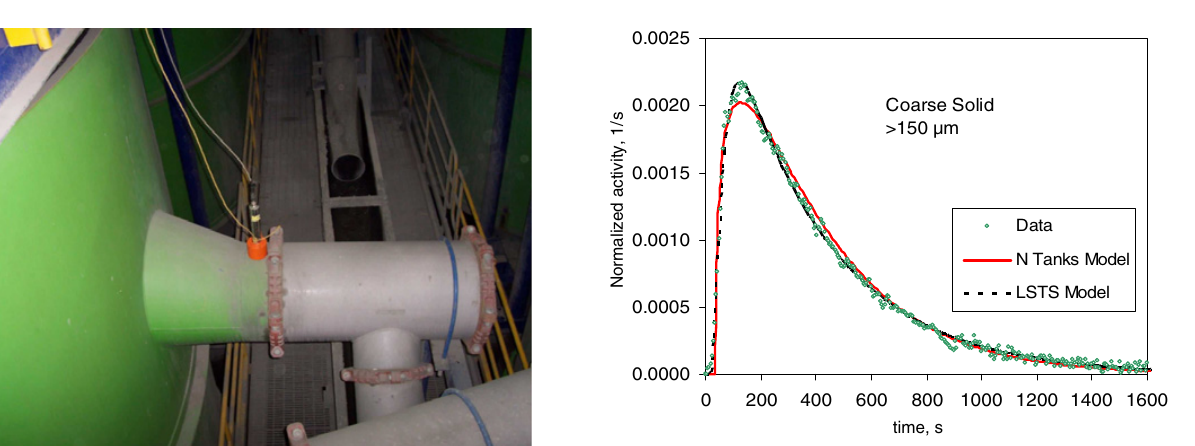
Figure 5. Sensor located on cell concentrate pipe.